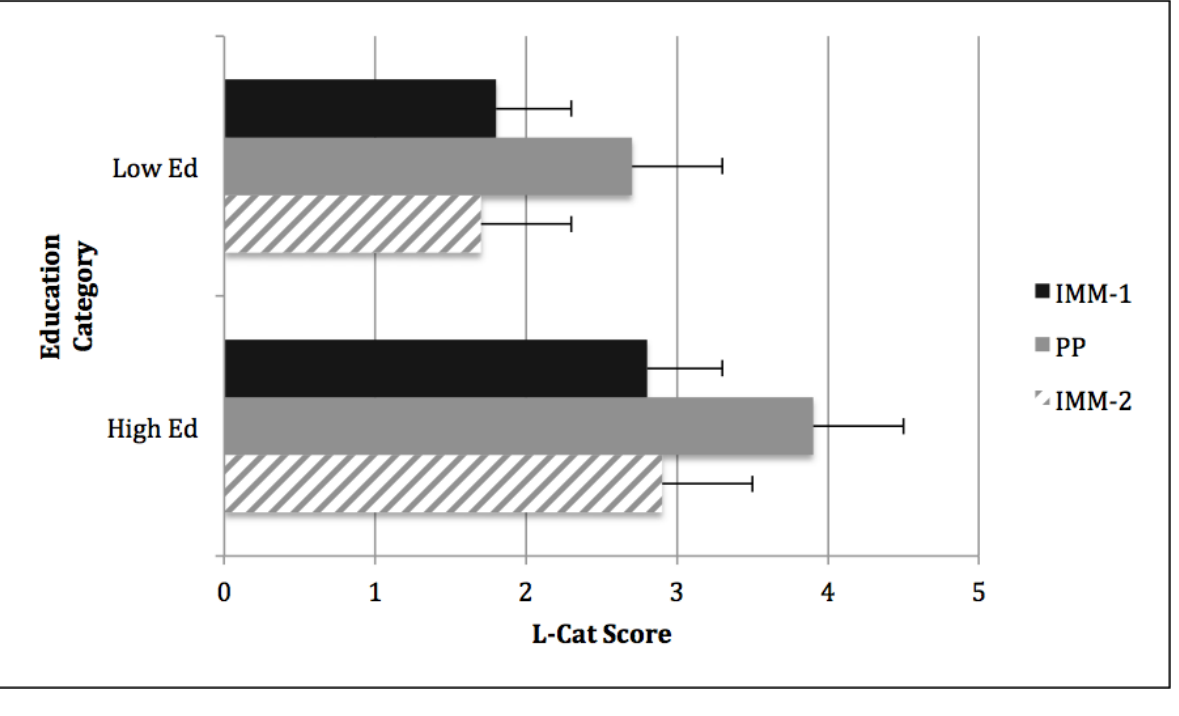
Figure 4. Comparison of education group responses on the Stanford Leisure-Time Activity Categorical Item (L-Cat). The following abbreviations mean: Low Ed=Less than high school/high school; High Ed=Some college/college degree; IMM=Interactive Multi-media, two separate administrations; and PP=Paper and Pencil version. The "Low Ed" top black solid bar shows the significant difference from the "High Ed" group ( P =.008). The "Low Ed" center grey solid bar shows the significant difference from the "High Ed" group ( P =.002). The "Low Ed" bottom grey-striped bar shows the significant difference from the "High Ed" group ( P =.001). The "Low Ed" and "High Ed" center solid grey bars show the significant difference from "IMM-1" and "IMM-2" (both P